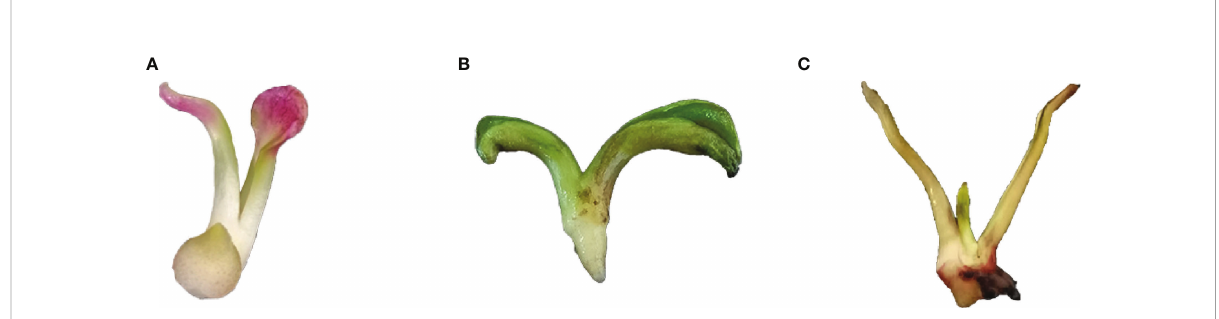
FIGURE 2 Growth States of P. lacti fl ora embryos during tissue culture. (A-C) Embryos at 30 (A) , 45 (B) and 60 (C) d after germination, respectively.